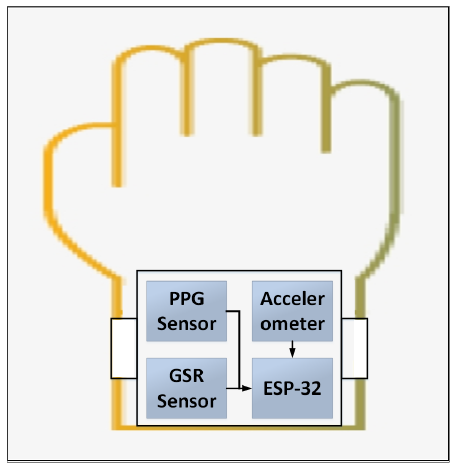
Figure 2. Wristband A prototype composition.